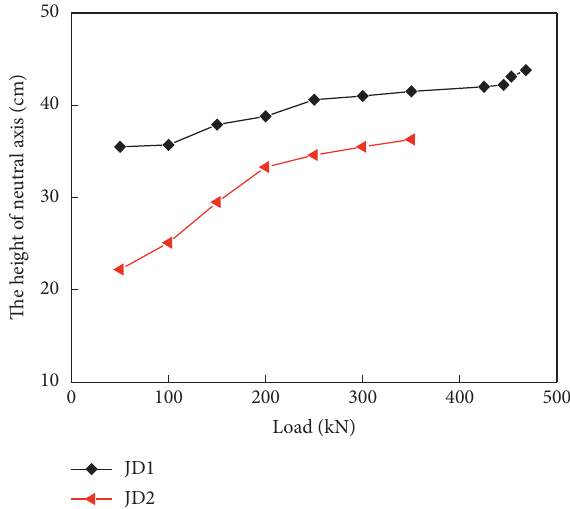
Figure 13: Height-load variation corresponding to the neutral axis.